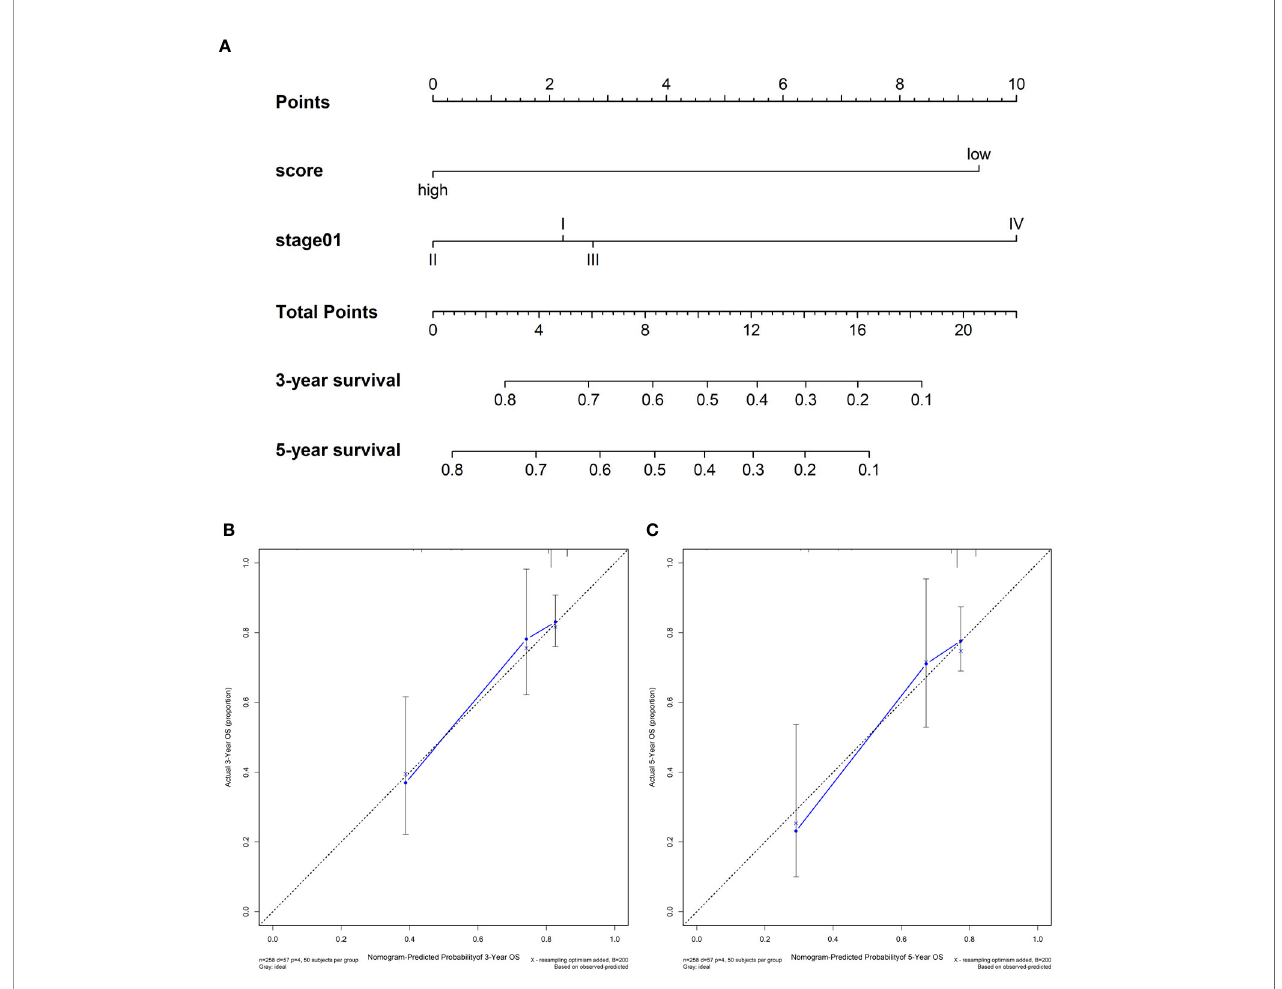
FIGURE 5 | (A) Nomograms for predicting the probability of patient mortality at 3- or 5-year OS based on IPRS. (B, C) Calibration curves of the nomogram for predicting the probability of OS at 3- and